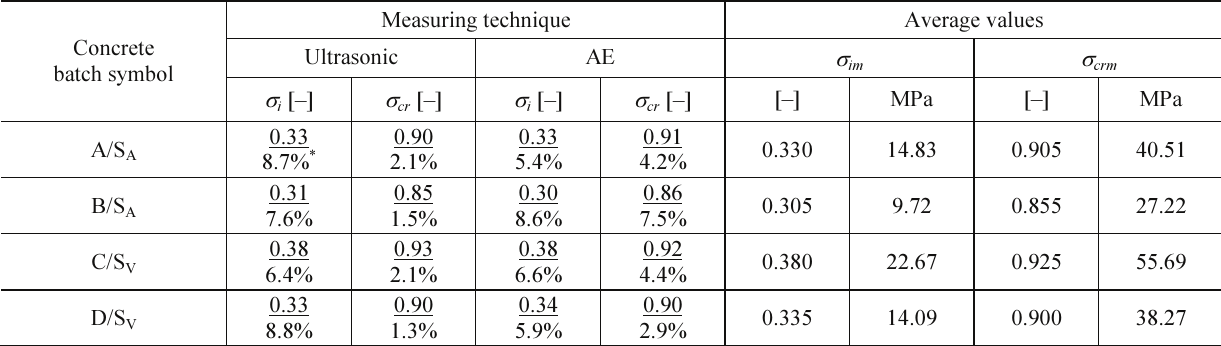
Table 4. Levels of stress σ i and σ cr and (relative and absolute) average values of σ im and σ crm stress levels in concretes A/S A , C/S V , B/S A and D/S V , determined by ultrasonic technique and AE technique Concrete batch